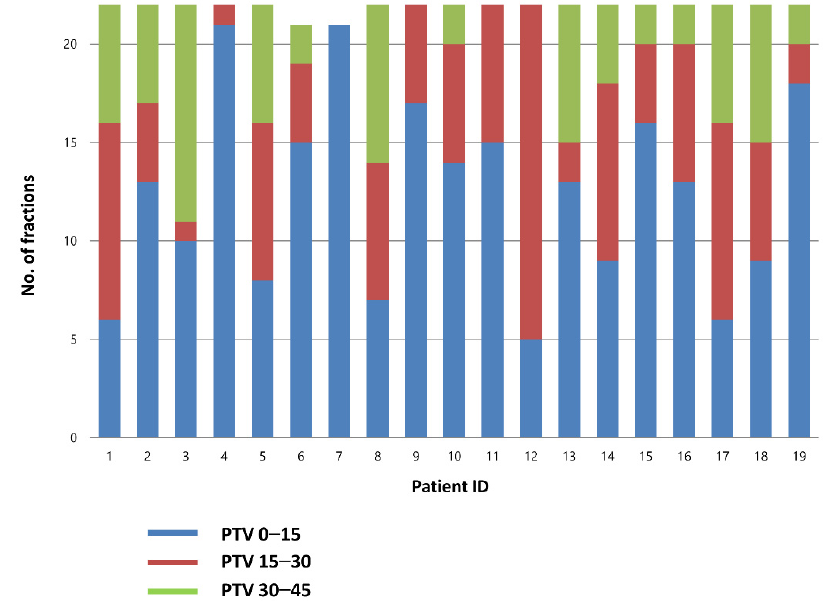
Figure 2. Choice of the PTV in each fraction. PTV, planning target volume.